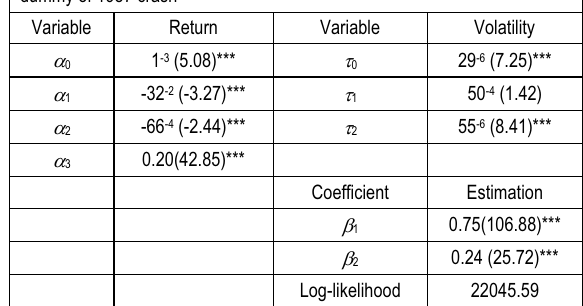
Table 5. Empirical results for the AR(1)-GARCH (1,1) model